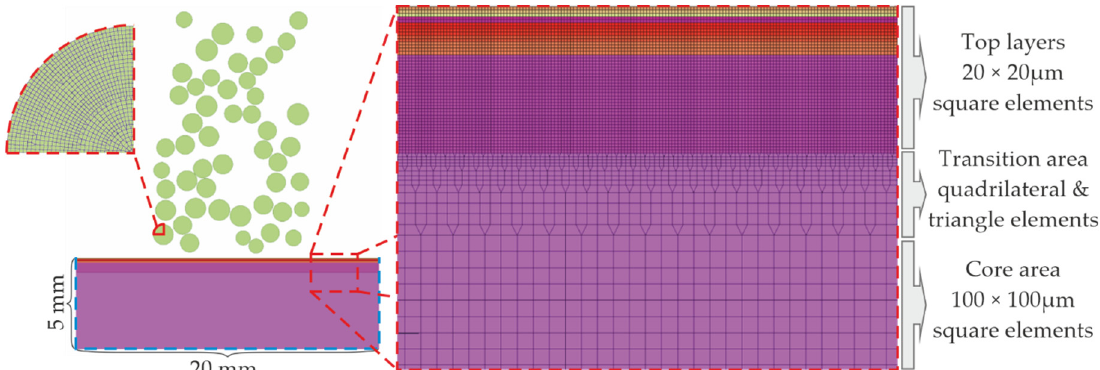
Figure 1. Specimen discretization strategy and essential dimensions [20].